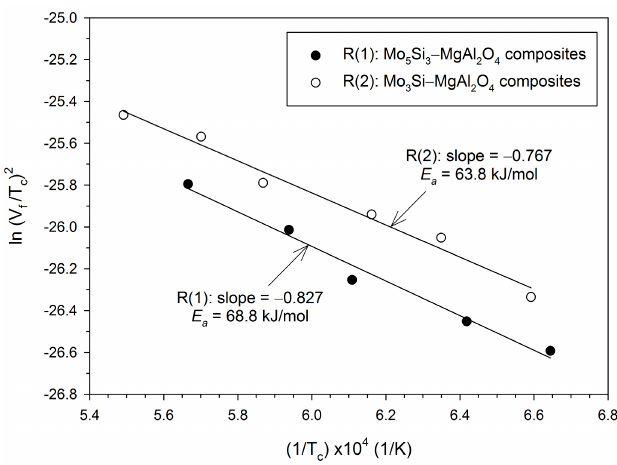
Figure 4. Correlation for determination of activation energies ( E a ) for formation of Mo 5 Si 3 – and Mo 3 Si–MgAl 2 O 4 composites from solid-phase combustion synthesis.